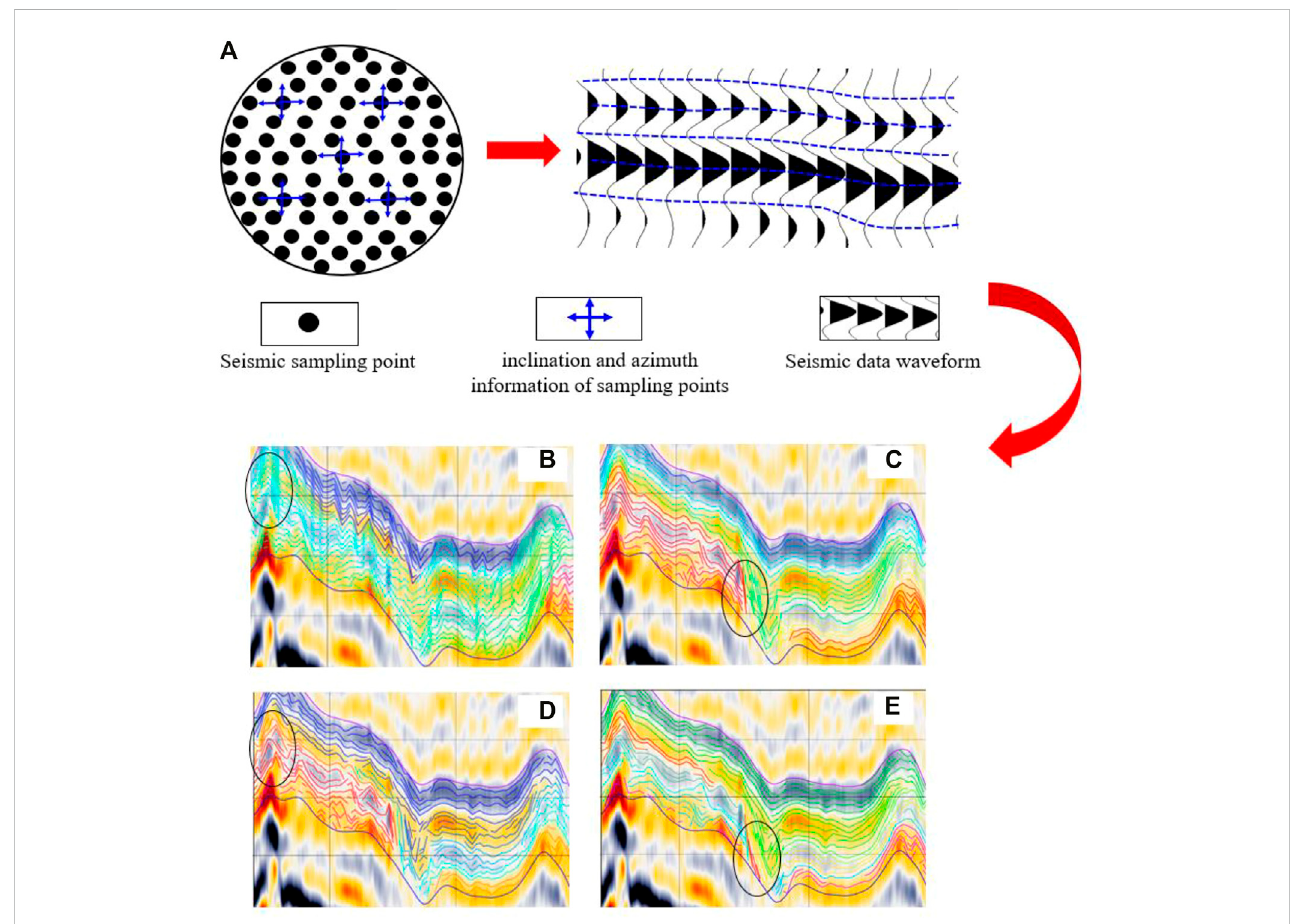
FIGURE 5 (A) Calculation andtrackingmodelofthehorizon; andComparison oflowerlevels withdifferentparameters; (B) FFF111_:thehorizonvolumecalculated by 333 algorithms (the horizon volume passes through the layer); (C) PCA111_: the horizon volume calculated by 333 algorithms (the degree of coincidence with the event axis is inadequate); (D) PCA111_ 11: horizons calculated by the algorithm (poor continuity of horizons); and (E) PCA111_: horizon volume calculated by 662 algorithms (the best coincidence